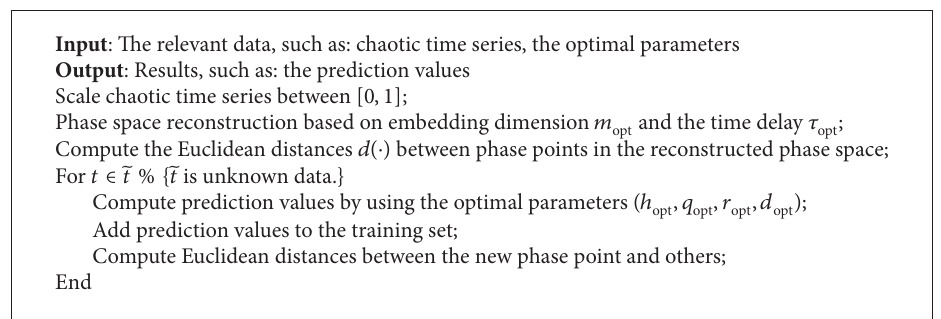
Algorithm 2: Multistep prediction